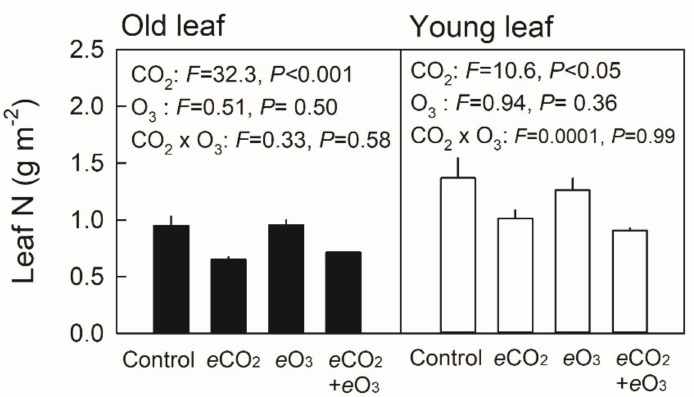
Figure 6. Area-based leaf nitrogen content in old (closed bars) and young leaves (open bars) of Japanese white birch seedlings grown under CO 2 and O 3 treatment combinations. Control—ambient air, eCO 2 —elevated CO 2 , eO 3 —elevated O 3 , and eCO 2 + eO 3 —elevated CO 2 and O 3 . Young leaves were ≈ 30 days old, and old leaves were ≈ 60 days old. F -value and probability ( P ) of the effects of CO 2 , O 3 and their interaction are indicated in the panel. Values are mean + SE ( n =